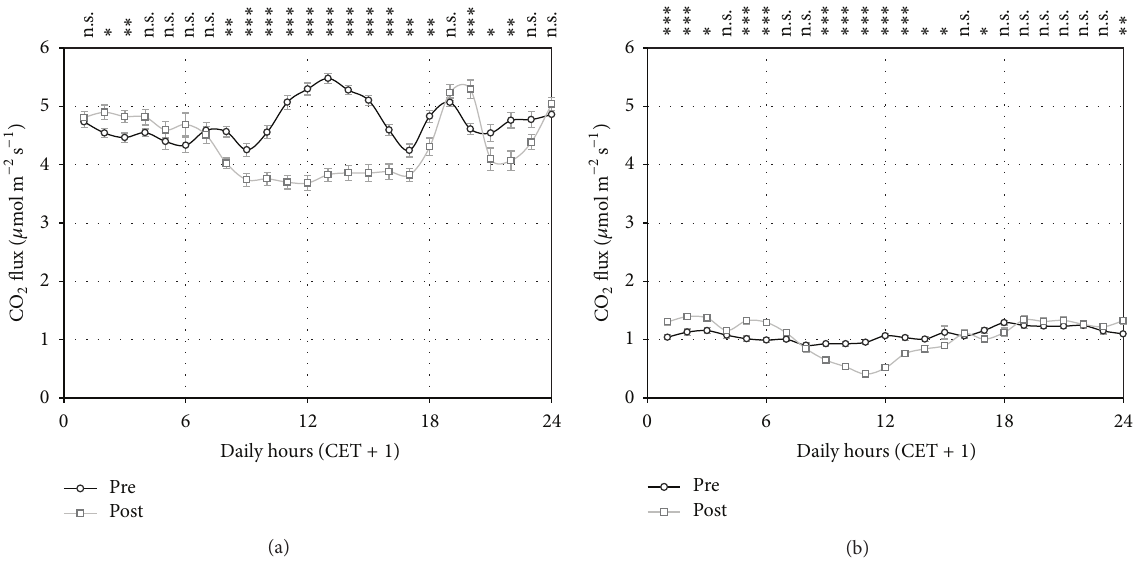
Figure 6: Comparison between the average daily courses of the CO 2 fluxes of one week before (pre) and one week after (post) harvest at the NT site (a) and CT site (b). Vertical bars indicate the standard errors of the means. (CT = conventional tillage site; NT = no-tillage site.) The statistical significance of the differences between the flux daily courses of the two periods in both sites has been reported (for each hour) at the top of each graph ( ∗ ∗ ∗ for 𝑃 < 0.001 ; ∗∗ for 𝑃 < 0.01 ; ∗ for 𝑃 < 0.05 , and n.s. for 𝑃 > 0.05 ).